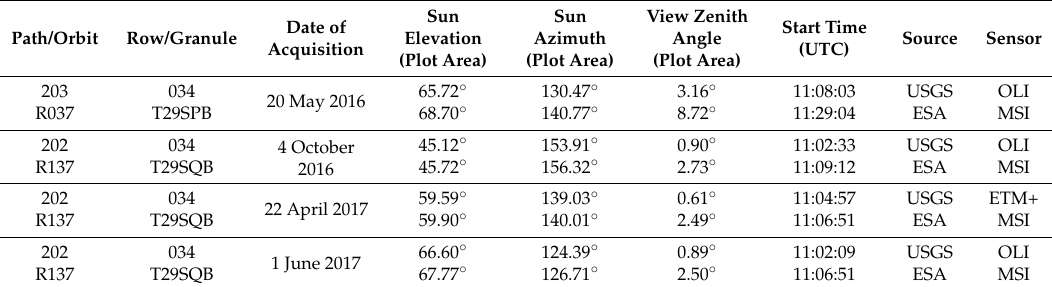
Table 1. Features of Landsat-7, Landsat-8 and Sentinel-2A imagery used in the study.